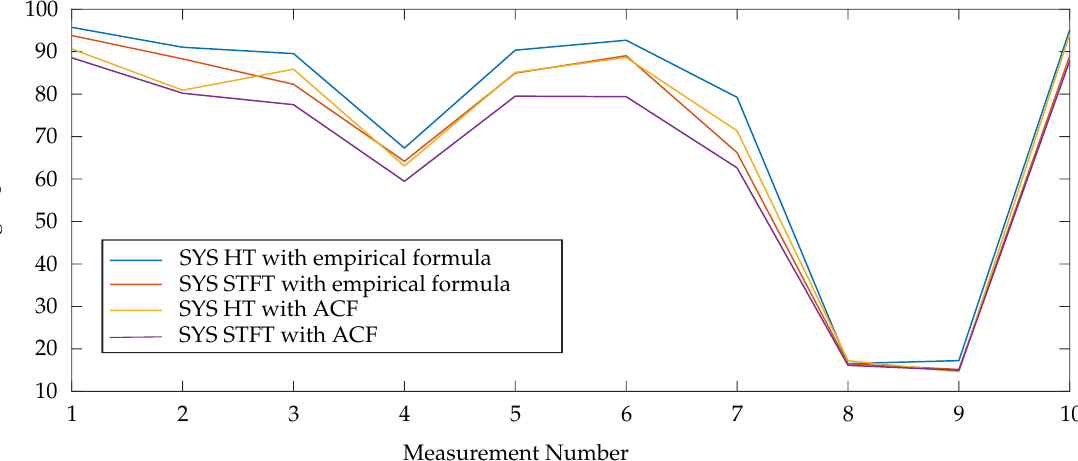
Figure 9. Comparison of the ACF-based and the empirical-based method for the systolic length estimation: the average F 1 -score is plotted over the ten conducted